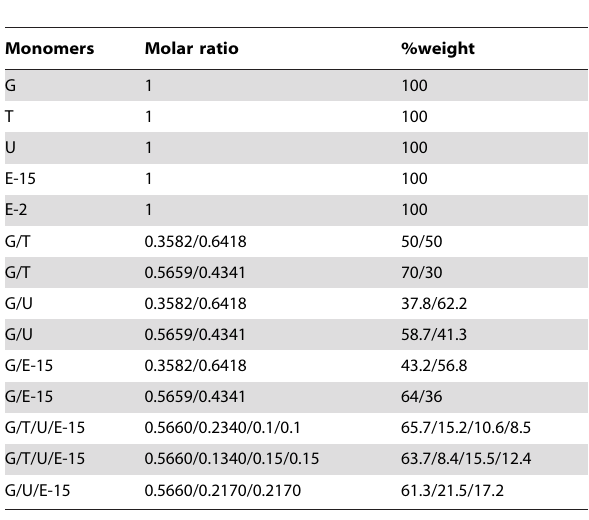
Table 2. Composition of experimental